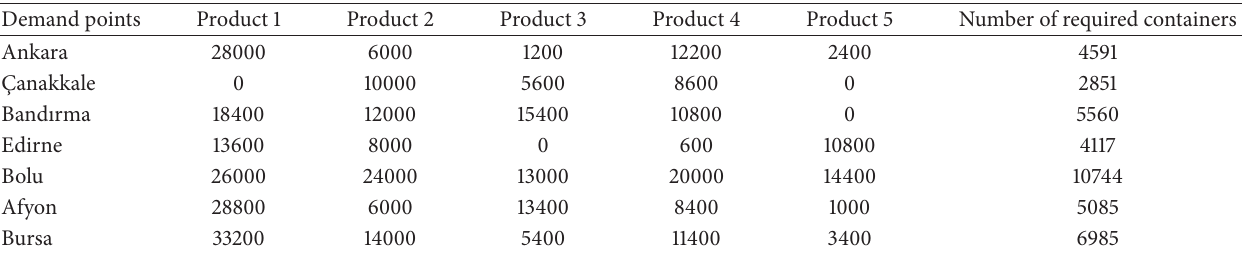
Table 17: Product based demand quantities of the demand points (unit).